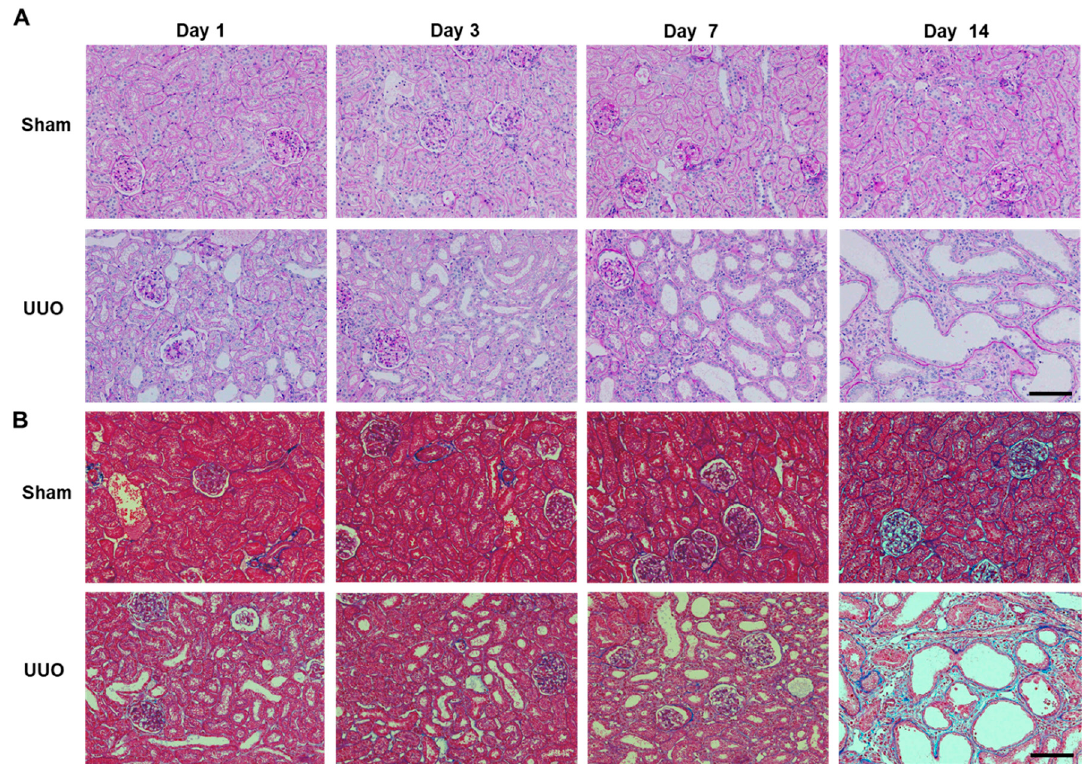
Figure 2. Histological images of obstructed kidneys of rats with UUO. ( A ) Periodic acid-Schiff (PAS) staining of sham-operated kidney (Sham) and obstructed kidney (UUO). There was obvious renal tubular damage on days 7 and 14. Scale bar: 100 μ m. ( B ) Masson’s trichrome staining microphotographs of sham-operated kidney (Sham) and obstructed kidney (UUO). Focal fibrotic changes on day 7 became severe on day 14. Scale bar: 100 μ m.